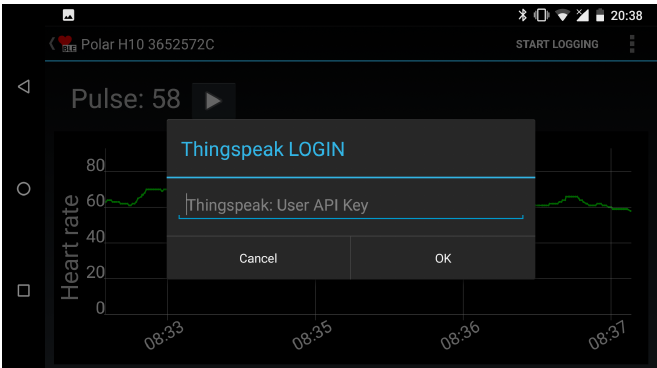
Figure 3. HeartCare app login